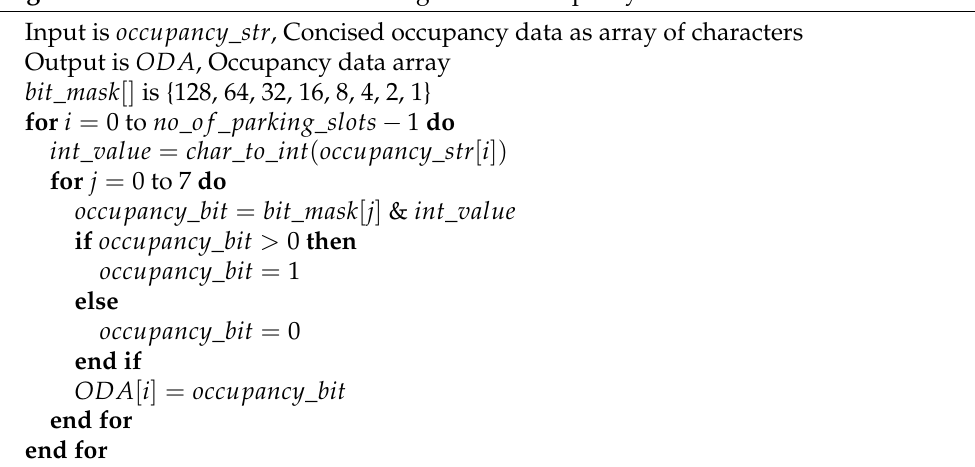
Algorithm 2 Convert the concise string back to occupancy